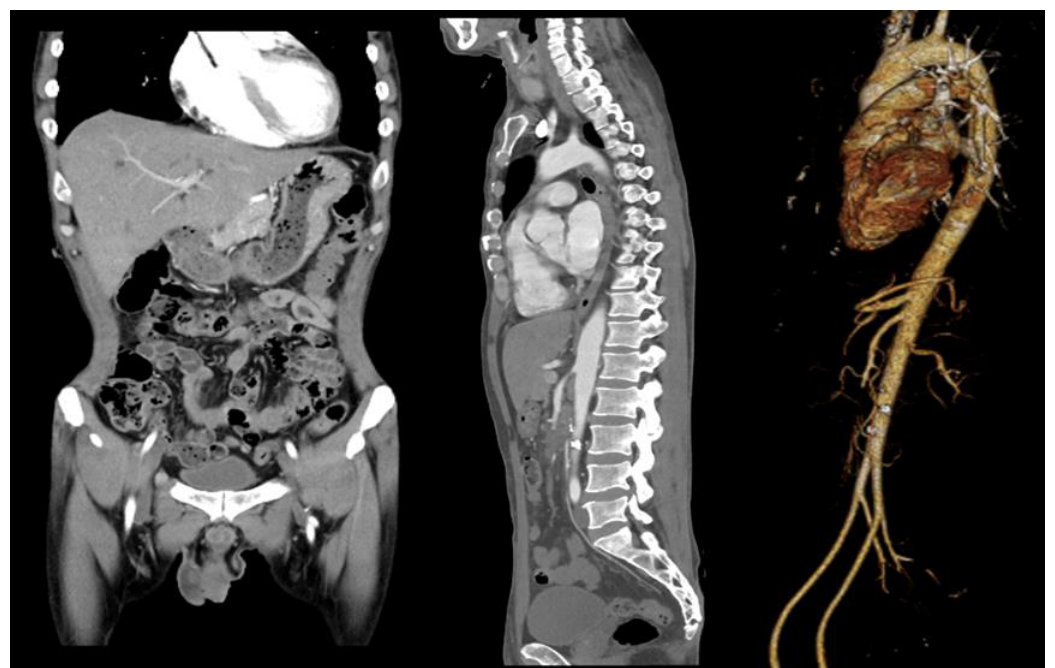
Figure 1. Initial computed tomography (CT) scanning performed in the emergency room showing superior mesenteric artery (SMA) embolism (coronal, sagittal, angio).